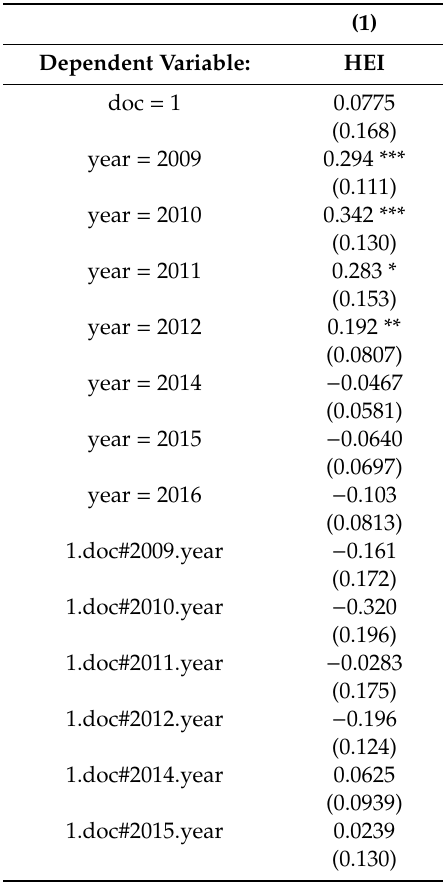
Table A10. Test of common trend of DoC switchers and users in both